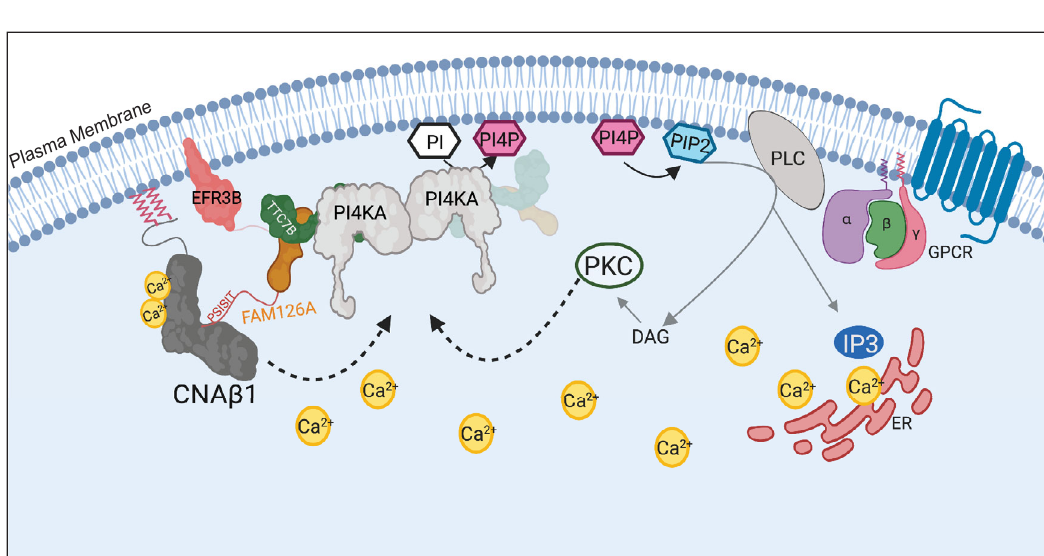
Fig. 7 Model for CNA β 1 mediated regulation of the PI4KA complex that promotes PI4P synthesis at the PM during GPCR signaling. Ligand binding and subsequent PLC-mediated cleavage of PI(4,5)P 2 generates DAG and IP3, which causes Ca 2 + release from the ER. This increase in intracellular Ca 2 + activates CN (CNA β 1), and PKC, which in turn regulate the PI4KA complex at the PM to promote PI4P and PI(4,5)P 2 replenishment. See text for details. Schematic generated using